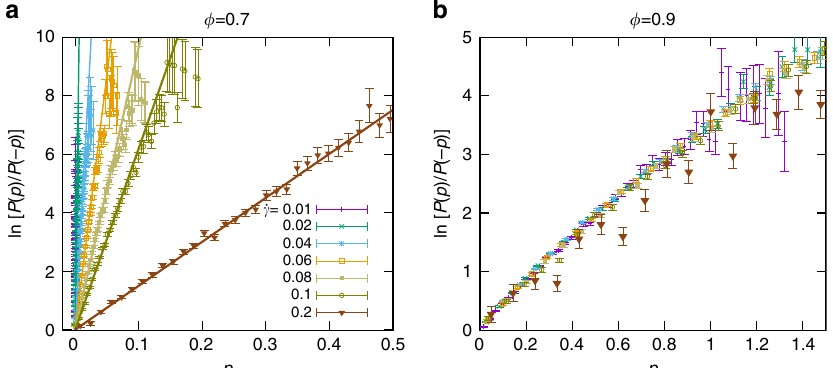
Fig. 3 Veri fi cation of the instantaneous FR. Plot of ln ½ P ð p Þ = P ð(cid:3) p Þ(cid:4) vs. p for two packing fractions a ϕ = 0.7 and, b ϕ = 0.9. The solid lines are linear fi ts of slope β e = τ / T e of the data for different shear rates. The slope decreases by increasing the shear rate _ γ , implying that the effective temperature T e increases by _ γ . The slope has a weak dependence on _ γ in the jammed state. For n + and n − representing number of positive (+ p ) and negative ( − p ) cases, the corresponding error bar of P ( p )/ P ( − p ) is equal to (1/ n + +1/ n − )